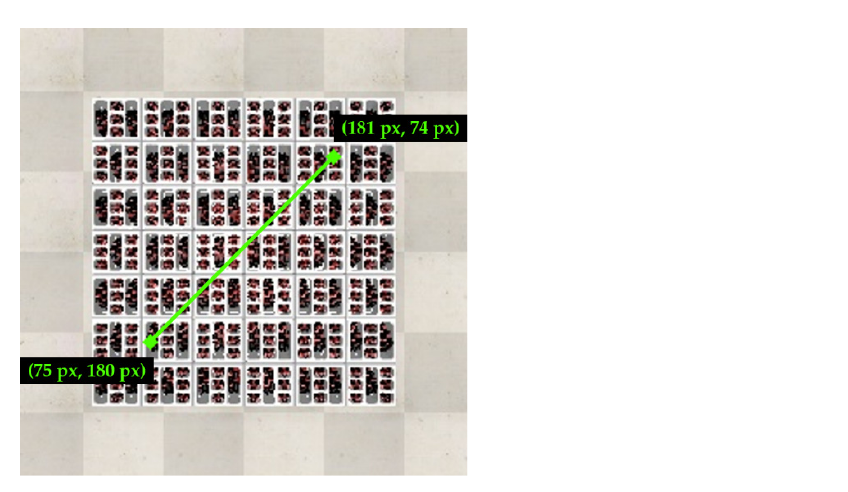
Figure 15. Diagonal-shaped trajectory for tracking evaluation of the EOCC.